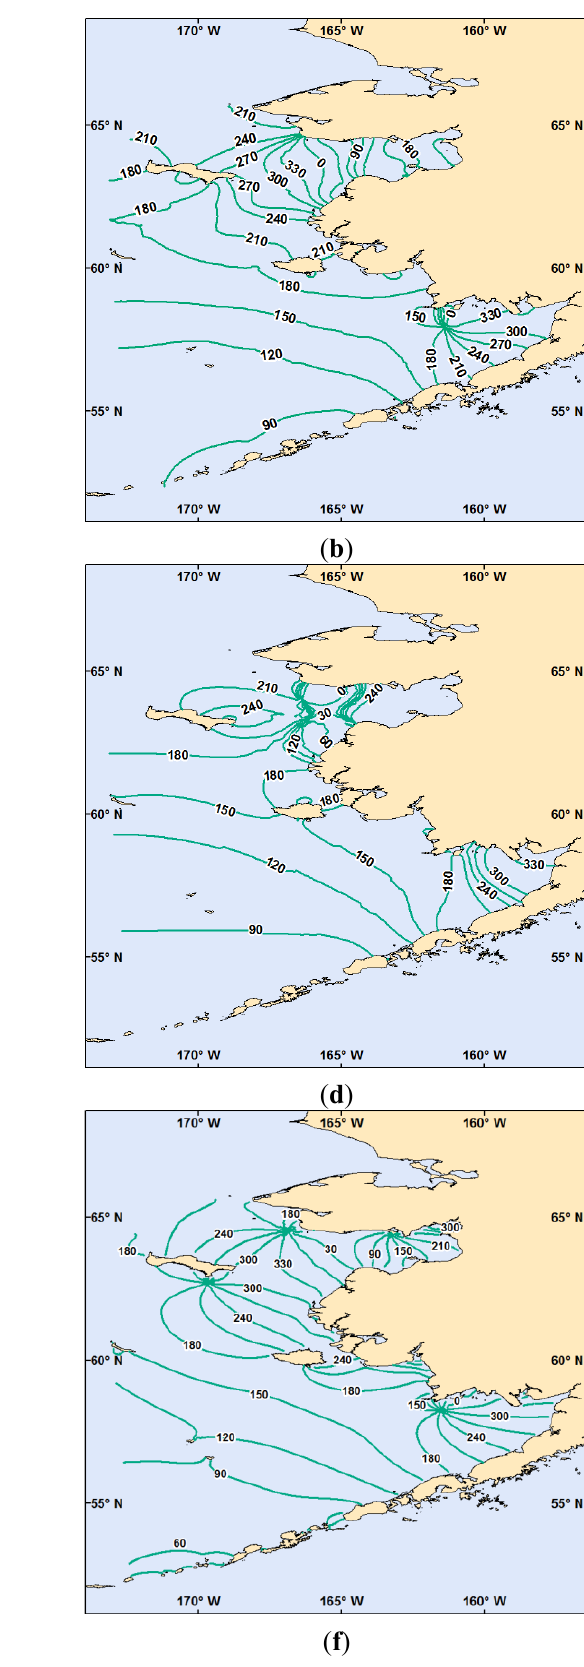
Figure 9. M co-amplitude ( left side panels) and co-phase ( right side panels) contours 2 from TOF ( a , b ); TO ( c , d ); and FM ( e , f